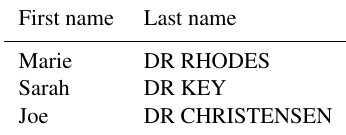
Table 2. Output of Example